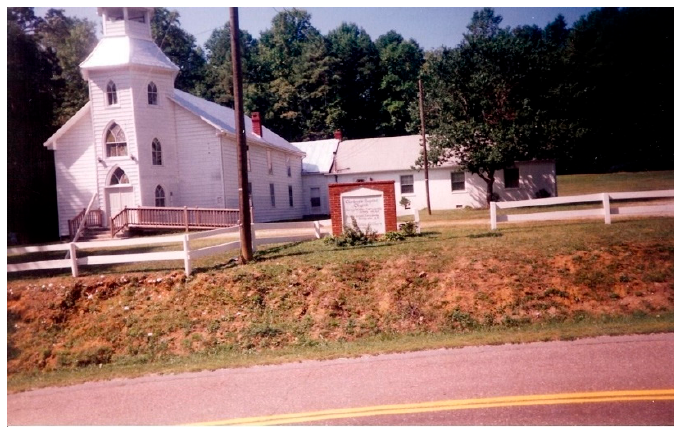
Figure 2. Clarkesville Baptist Church.